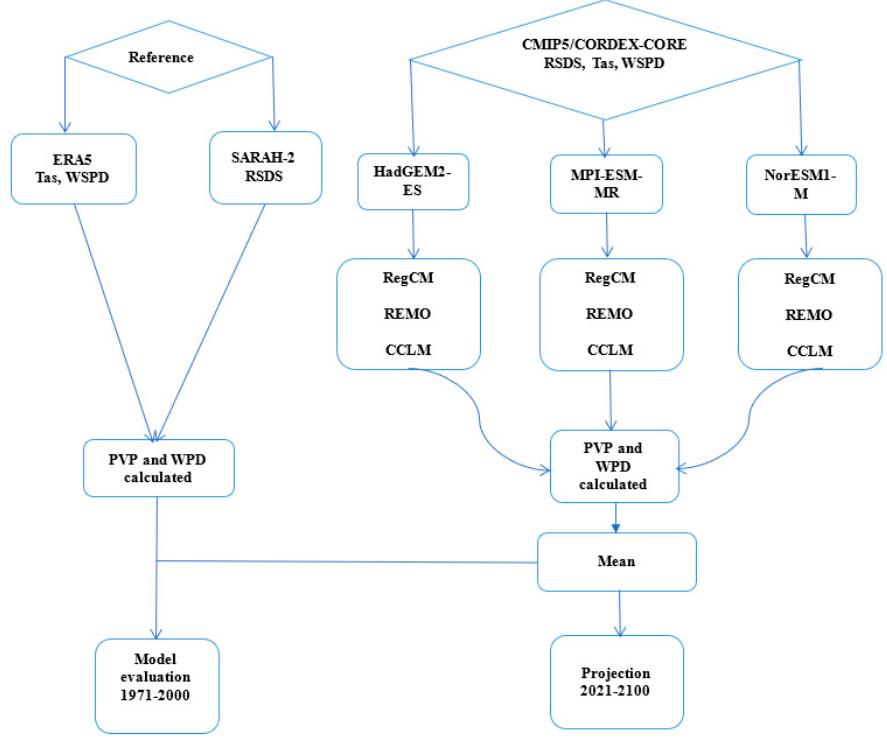
Figure 2. Conceptual framework of the research methodology including the main target variables (e.g., PVP and WPD), the chosen RCMs/GCM combinations of CORDEX-CORE for providing climate projections and the reference datasets used for model evaluation.